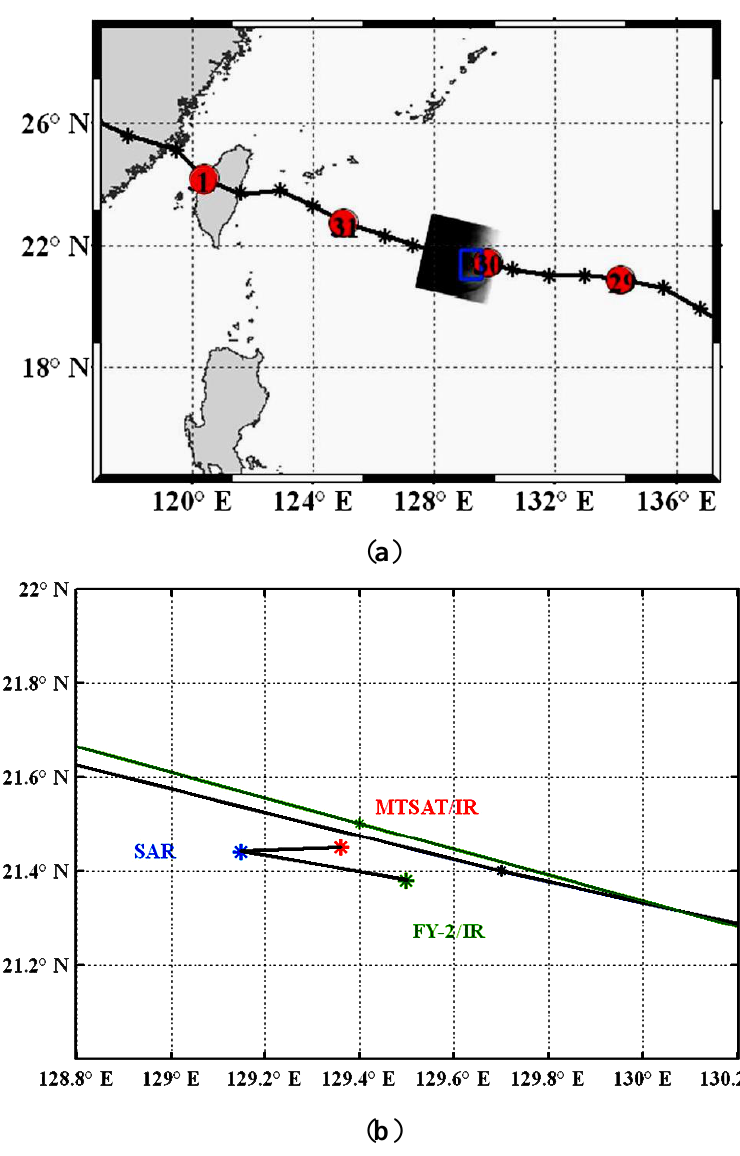
Figure 6. ( a ) Regional typhoon track map from 29 August to 1 September; and ( b ) extracted typhoon eyes’ center from Envisat SAR data, FY-2 (black dot) and MTSAT IR images when Typhoon Talim was approaching Taiwan on 30 August 2005. The blue line for the best track from CMA is coincided with black line from